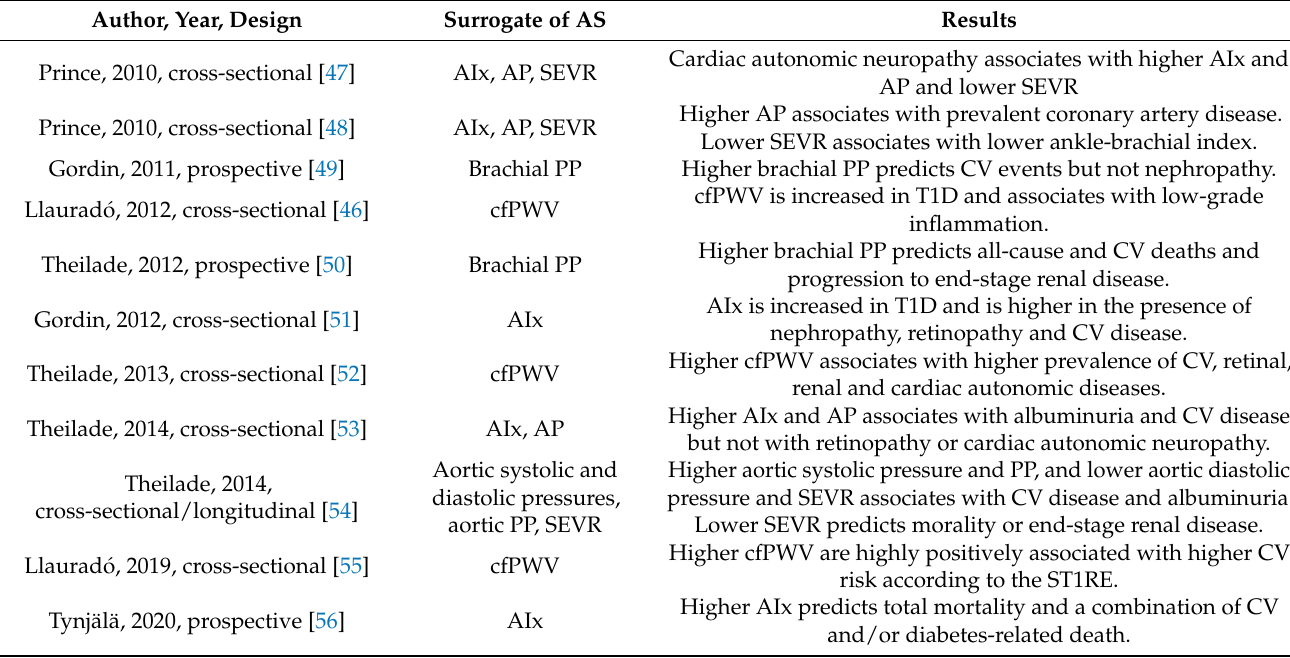
Table 2. Main studies on arterial stiffness in adults with